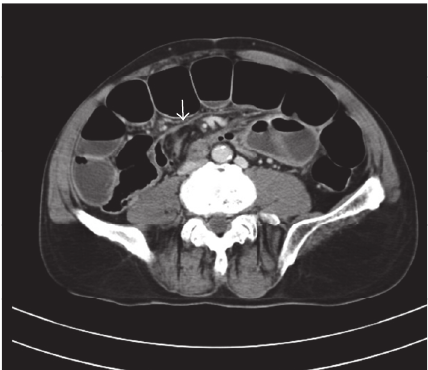
Figure 2: CT abdomen axial view showing band like structure extending from the distal ileum (white arrow).